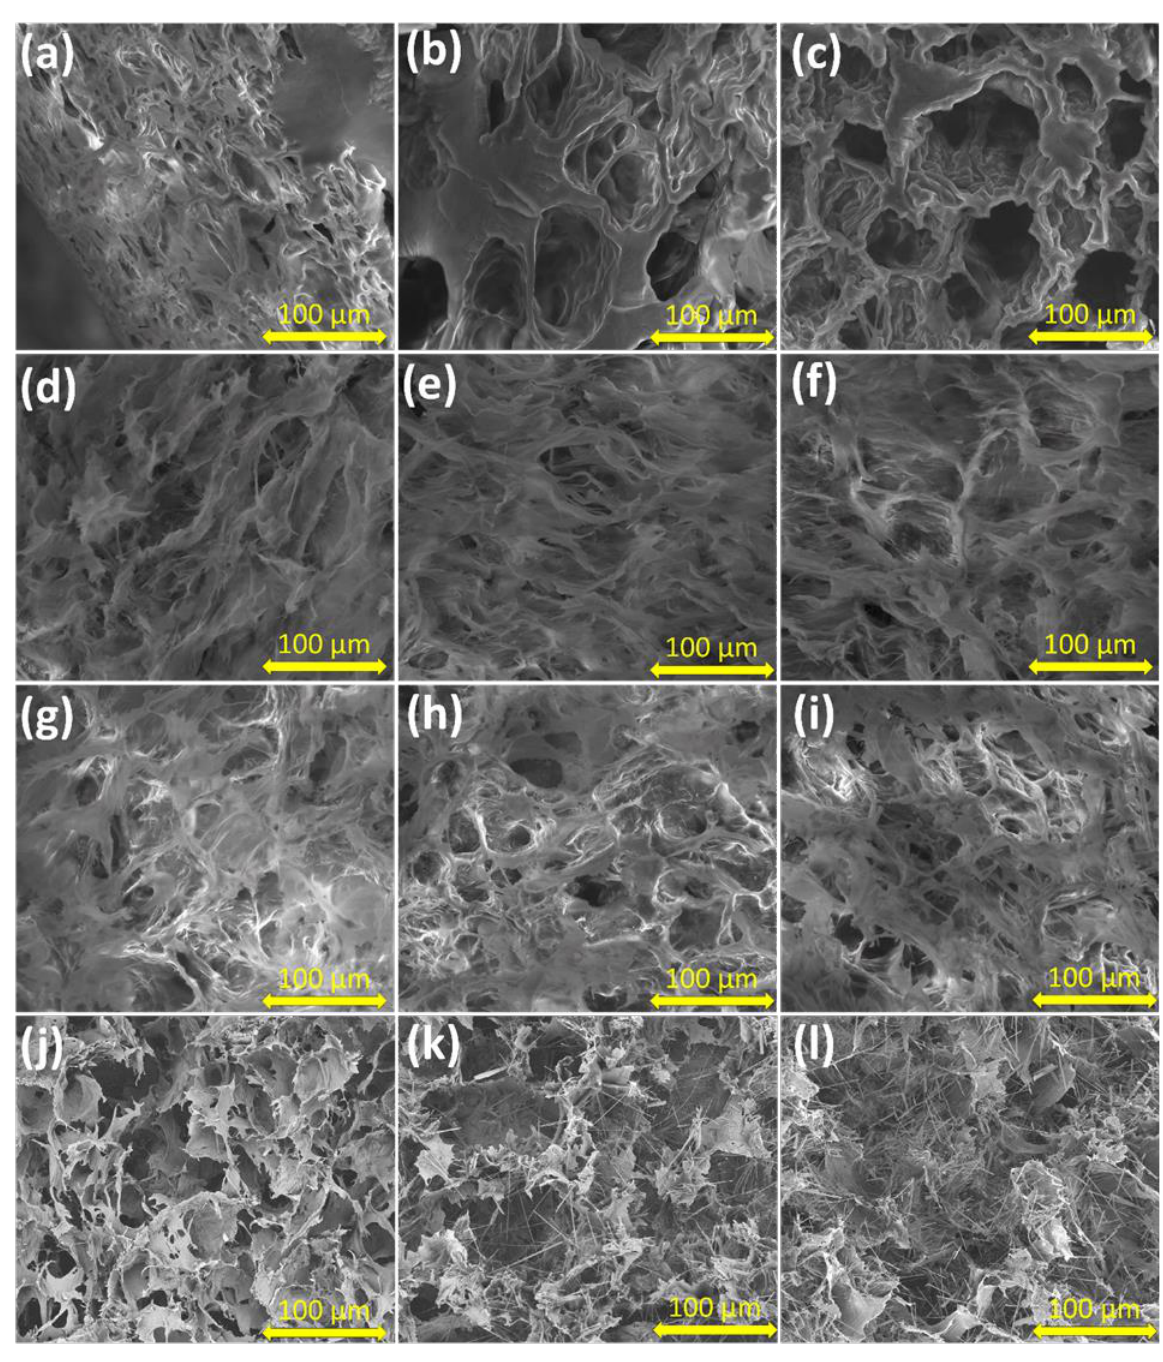
Figure 2. SEM images of hydrogels: ( a ) PVA_L-arg:CS 90:10; ( b ) PVA_L-arg:CS 75:25; ( c ) PVA_L-